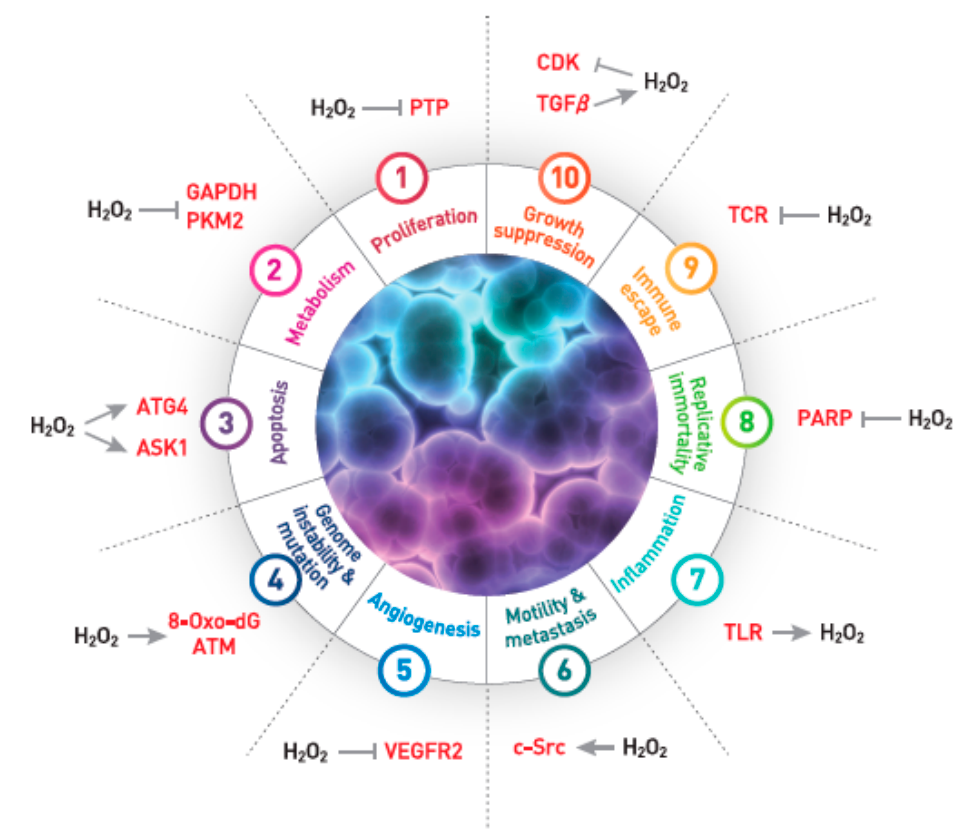
Figure 2. Involvement of H 2 O 2 in the hallmarks of cancer. Key signaling molecules activated ( → ) or inhibited ( ) by H 2 O 2 are depicted in relation to the hallmarks of cancer. PTP, protein tyrosine phosphatase; GAPDH, glyceraldehyde ‐ 3 ‐ phosphate dehydrogenase; PKM2, pyruvate kinase M2; ATG4, autophagy ‐ related 4; ASK1, apoptosis signal kinase 1; 8 ‐ Oxo ‐ dG, 8 ‐ oxo ‐ 2 ′‐ deoxyguanosine; ATM, ataxia telangiectasia mutated; VEGFR2, vascular endothelial growth factor 2; c ‐ Src, TLR, toll ‐ like receptor; PARP, poly(ADP ‐ ribose) polymerase; TCR, T cell receptor; CDK, cyclin ‐ dependent kinase; TGF, transforming growth factor.